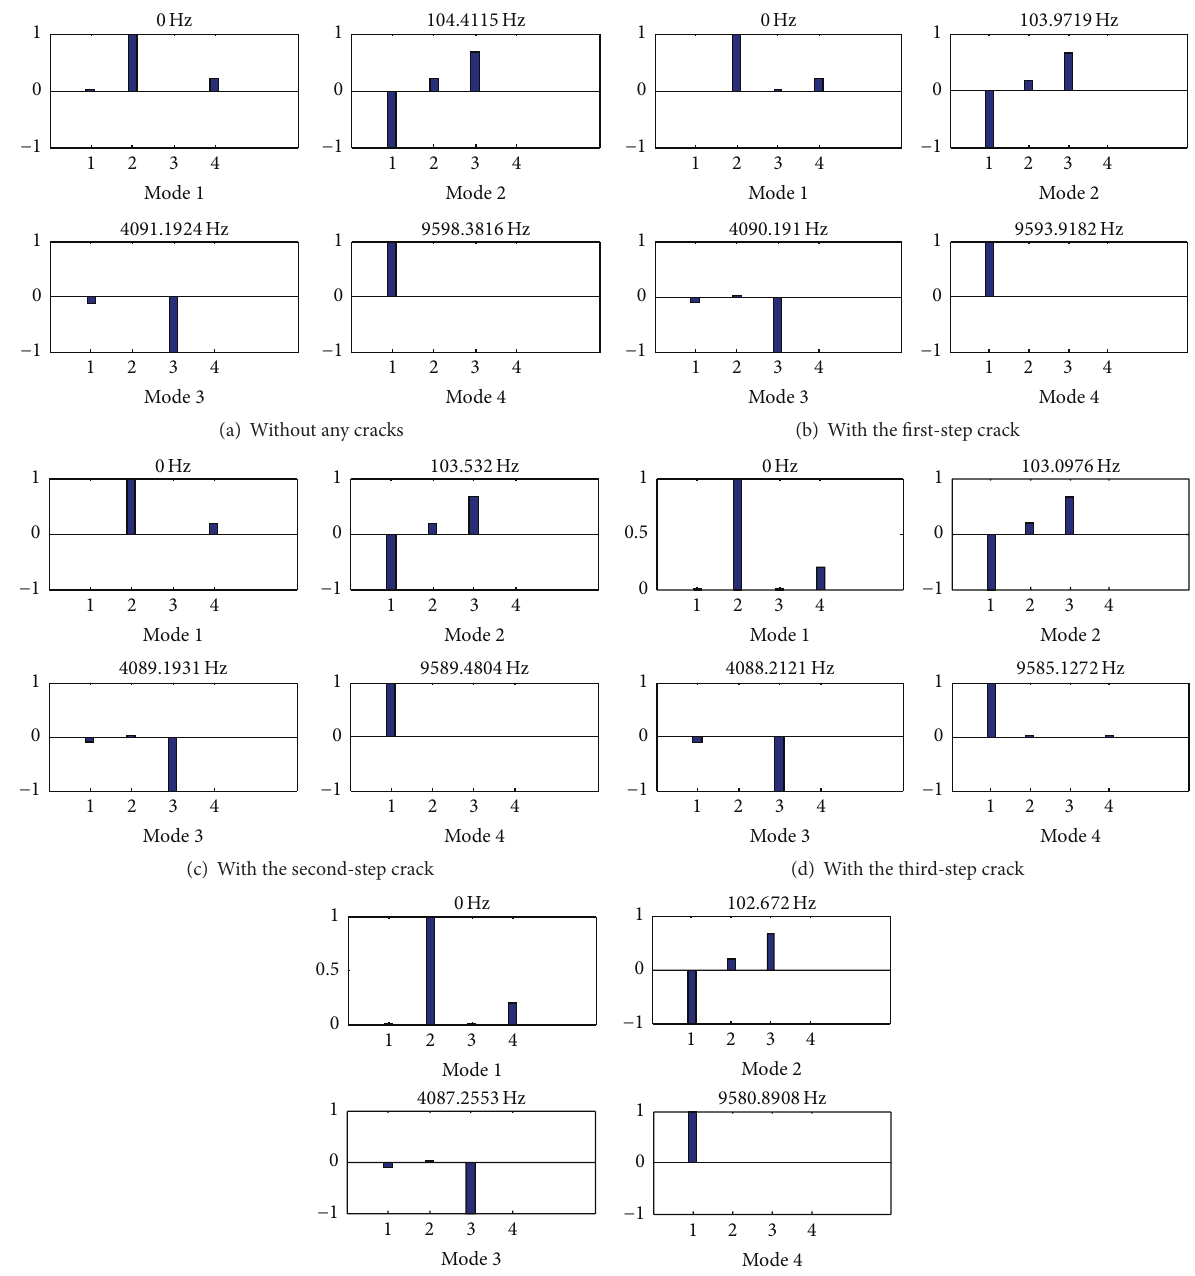
Figure 9: The simulations of natural frequencies of the example